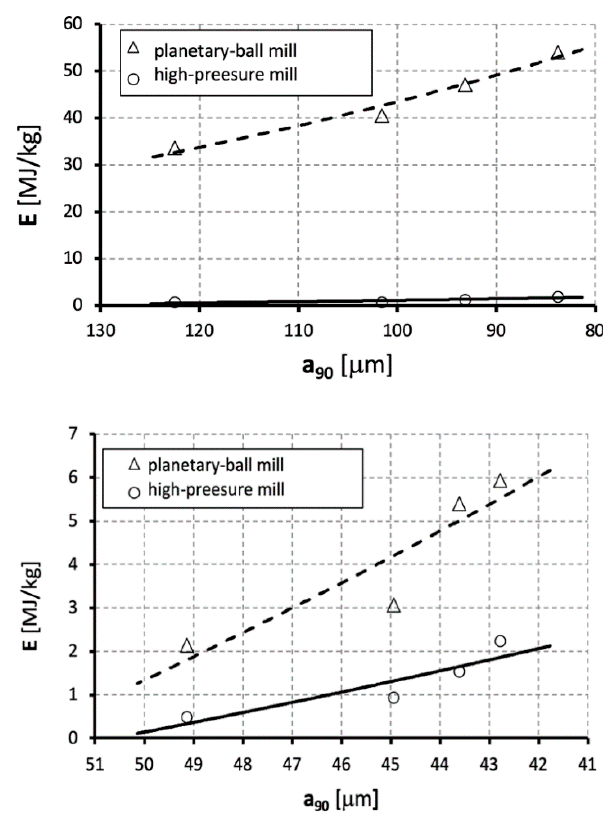
Figure 6. Dependence of the unit energy consumption of copper ore comminution on the efficiency of its milling process in a high-pressure hydro-jet mill (1) and in a planetary ball mill type (2) PM 100 ( n = 5 s − 1 ) for carbonate copper ore ( a ), sandstone ( b ) and shale ore ( c ).